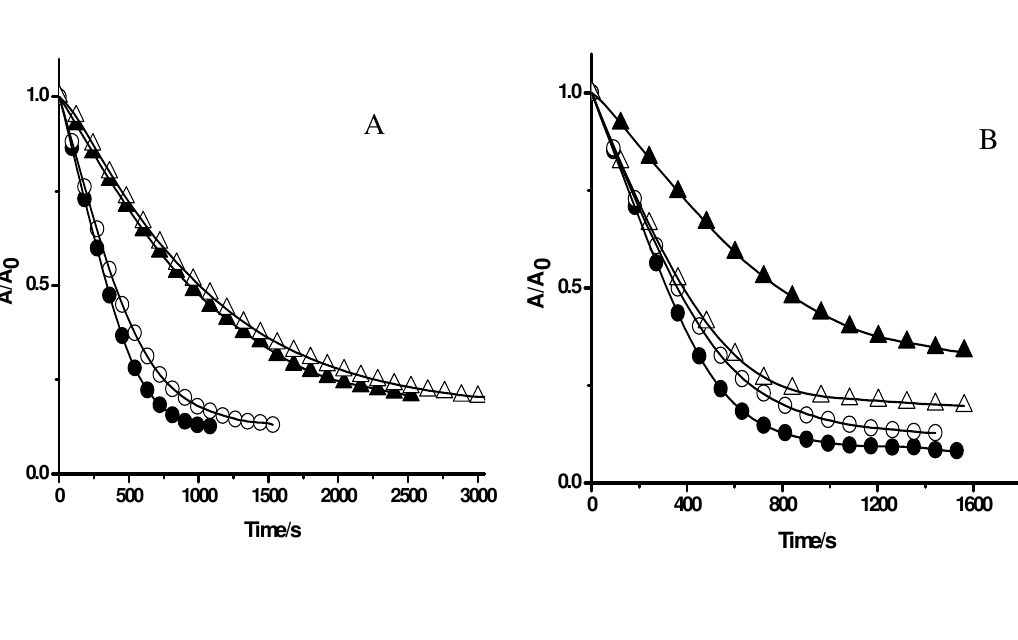
Figure 5. Effect of caffeic acid ( A ) and ethyl caffeate ( B ) on the consumption of PGR induced by AAPH derived peroxyl radicals in the absence and presence of Triton X-100 micelles. PGR (5 µM) was incubated with AAPH (10 mM) and the caffeic acid derivatives (at 250 µM) in micellar ( (cid:1) ) and phosphate solutions ( (cid:2) ). Control experiments without caffeic acid derivatives were carried out in the presence ( (cid:1) ) and absence ( (cid:1) ) of Triton X- 100